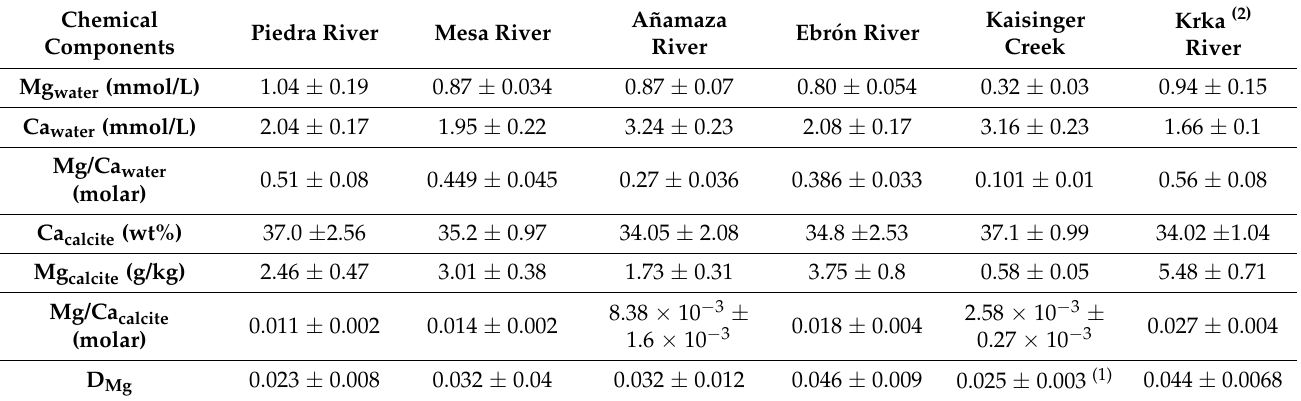
Table 1. Mean values (mean ± 1 σ ) for dissolved Mg, Ca and Mg/Ca ratios in waters (Mg water , Ca water and Mg/Ca water ) and stromatolites (Mg calcite , Ca calcite and Mg/Ca calcite ), and for the distribution coefficients in the studied sites at Piedra, Mesa, Añamaza and Ebr ó n Rivers. We also include data for the Kaisinger Creek [8] and Krka River [6] for